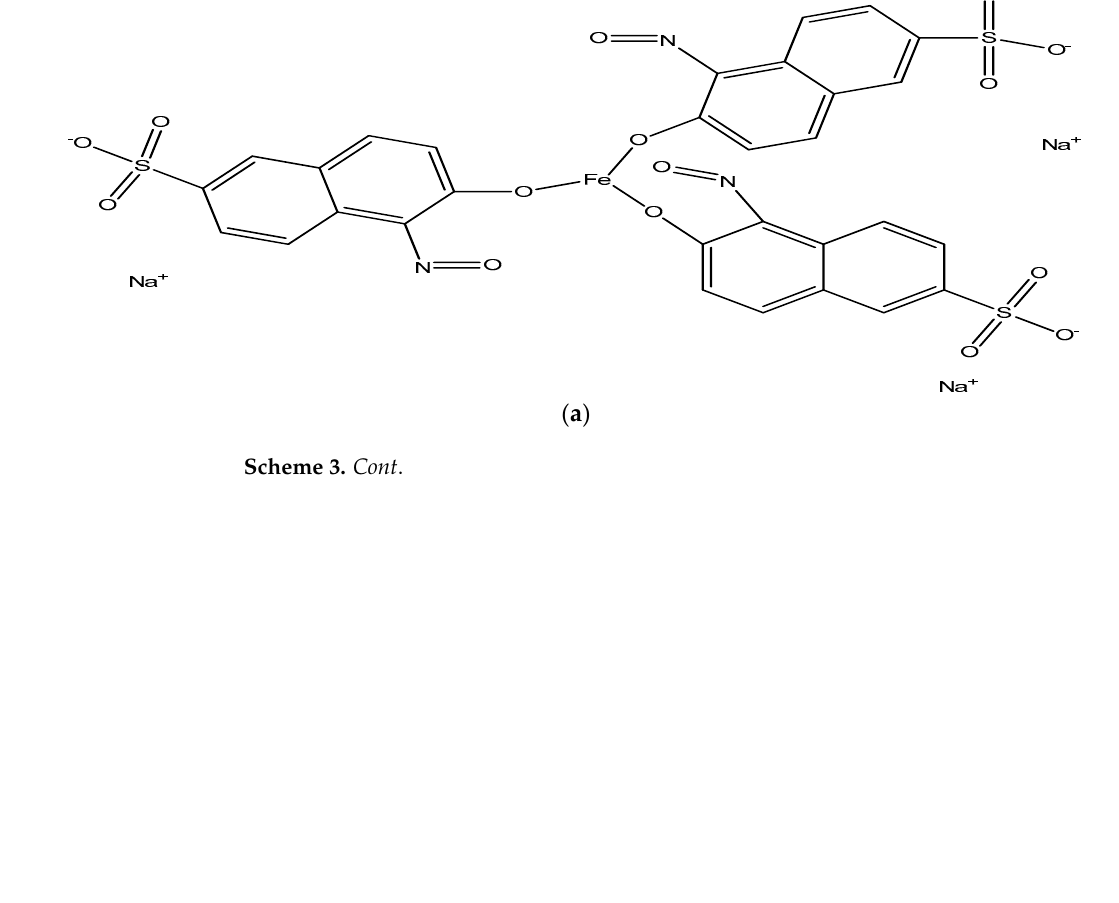
Table 8. Required details of chemicals and materials